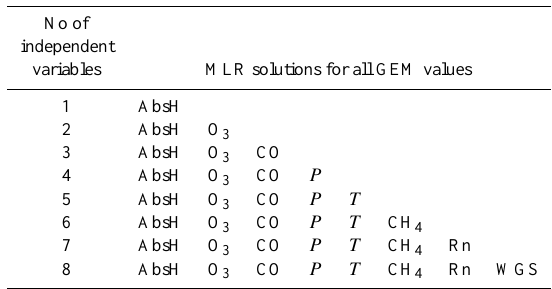
Figure 7. Determination of the optimum combination of indepen- dent variables to include in the MLR equation to calculate the de- pendant variable, i.e. GEM concentration (2007–2011). The root mean square error (RMSE) difference between the calculated and actual GEM concentrations indicated that the inclusion of eight pa- rameters in the MLR solution was the optimum. Table 2. The overall identity of independent variables during the determination of the optimum combination of independent variables for GEM calculation utilising the entire data